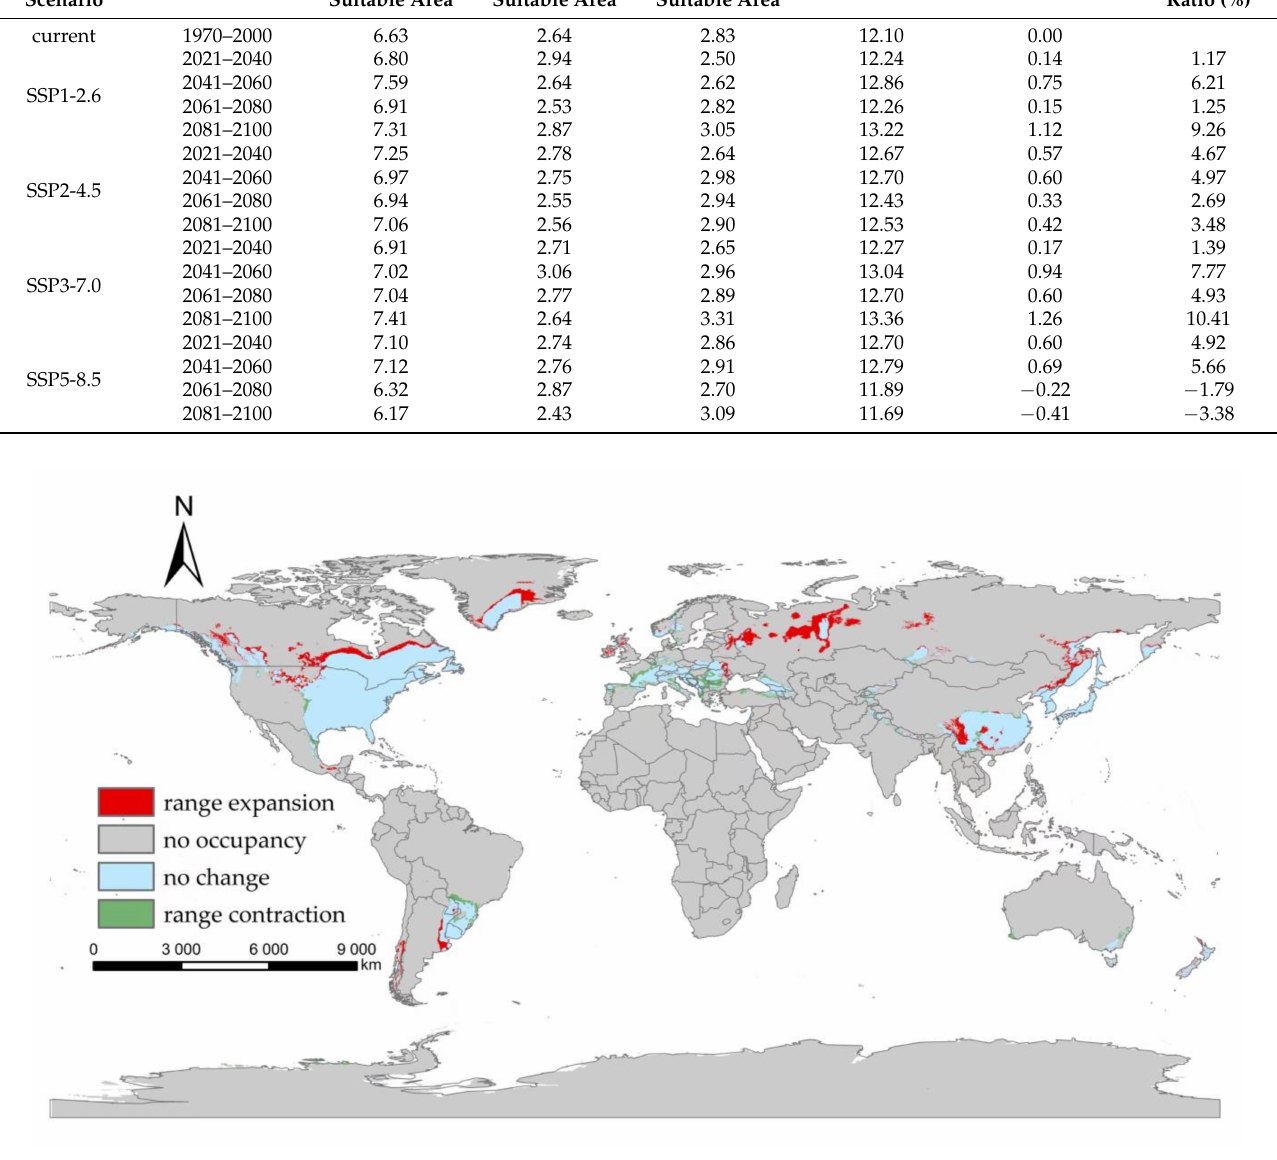
Figure 8. Comparison of the current suitable area with the period 2081–2100 under SSP3-7.0. Under various climate change scenarios, the minimum high suitable area was projected in the period 2021–2040 SSP1-2.6, reducing to an area of 2.50 × 10 6 km 2 . Compared with the current high suitable area, it decreased by 11.73% (Figure 10a). Under the SSP3-7.0, the projected high suitable area is the largest from 2081 to 2100, reaching 3.31 × 10 6 km 2 , an increase of 16.79% over the current climate conditions (Figure 10c). Middle suitable areas show a downward trend under SSP2-4.5 (Figure 10b). Under the SSP5-8.5 scenario, there will be a significant contraction of the low suitability area (Figure